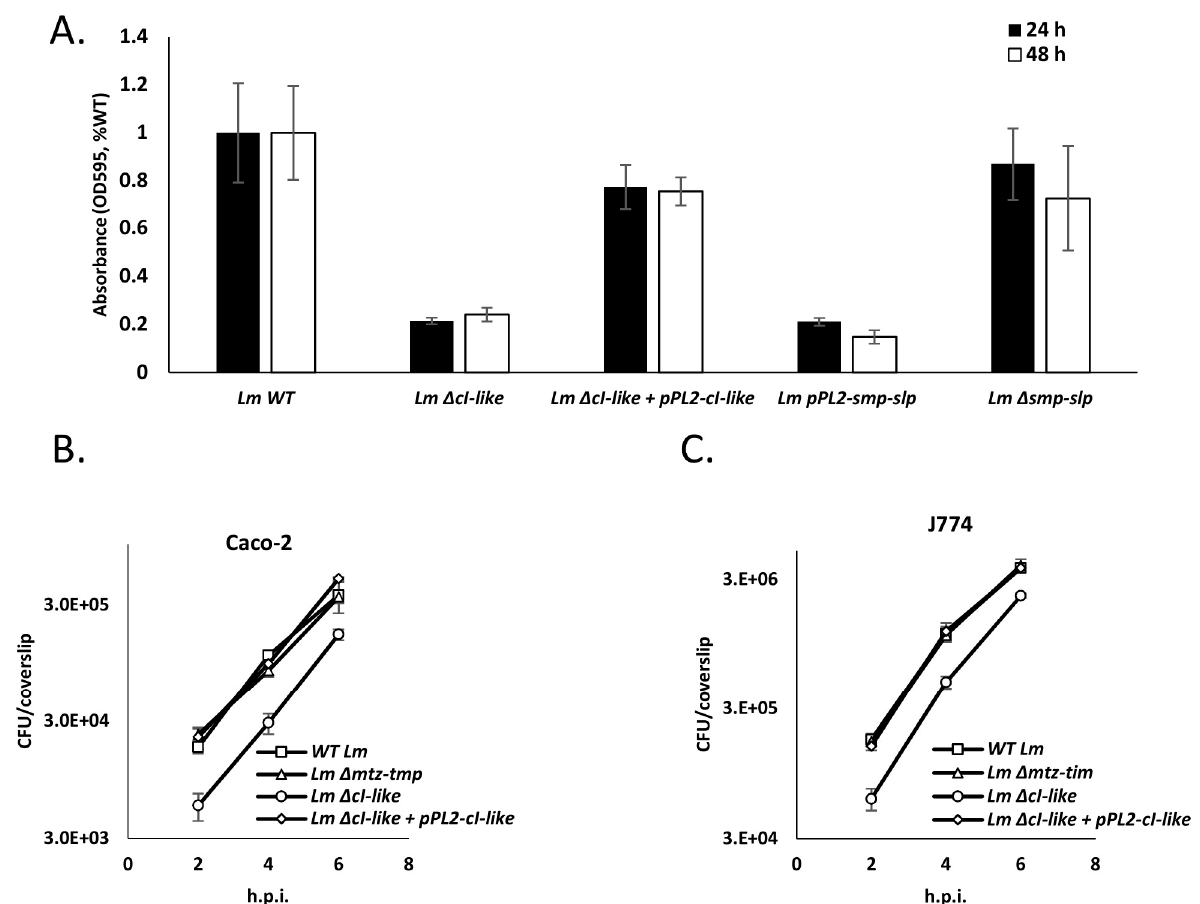
Figure 8. Ectopic expression of Mtz-Tim hinders mammalian cells invasion and biofilm production. ( A ) Biofilm formation analysis of WT Lm , WT Lm harboring pPL2 integrative plasmid expressing mtz-tim from an inducible p tetR promoter (pPL2- mtz-tim ), ∆ mtz-tim , ∆ cI -like and ∆ cI -like harboring pPL2 plasmid expressing cI- like from an inducible p tetR promoter (pPL2- cI- like) following 24 h of incubation in BHI at 37 ◦ C without shaking. The data represent three independent experiments, error bars represent the standard deviation of triplicates. ( B ) Intracellular growth analysis of WT Lm , and ∆ mtz-tim , ∆ cI- like and ∆ cI- like harboring pPL2 plasmid expressing cI- like from an inducible p tetR promoter (pPL2- cI- like) in J774 or Caco-2 ( C ) cells. The same number of bacteria were used to infect the cells. The data represent three independent experiments, error bars represent the standard deviation of triplicates.